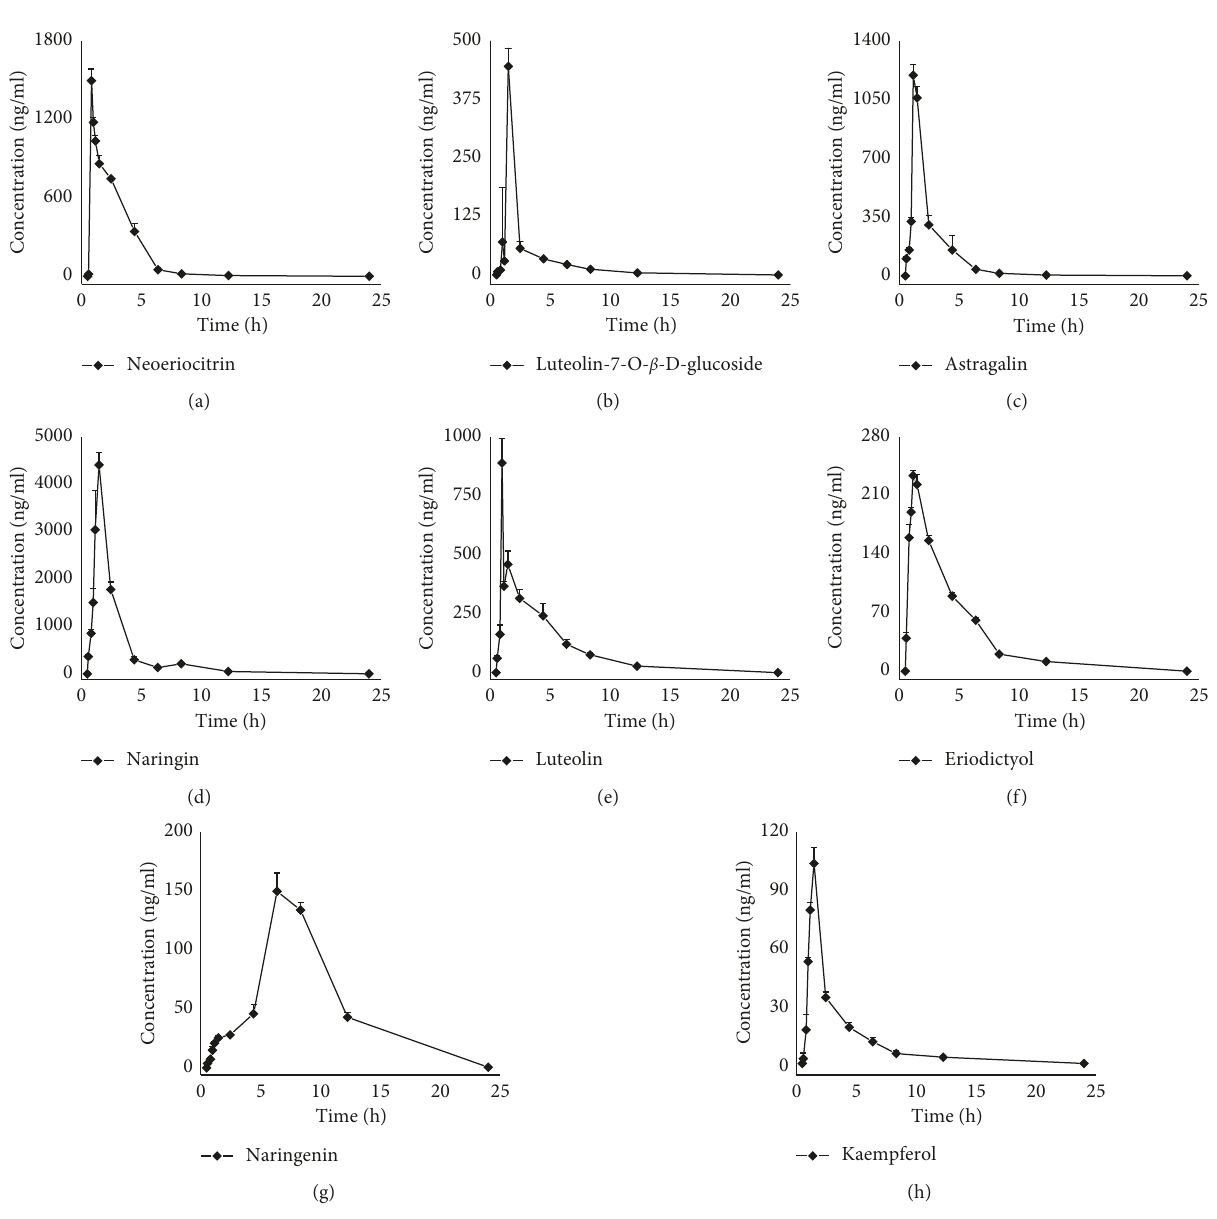
Figure 3: Mean plasma concentration-time curve of eight analytes in rats after oral administration of DRE. Table 6: Pharmacokinetic parameters of eight analytes in rat plasma after oral administration of DRE (mean ± SD, n � 6).